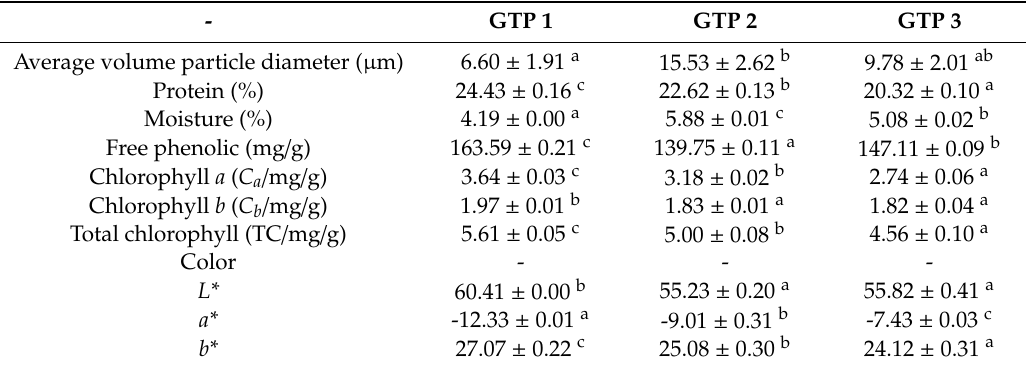
Table 1. Particle sizes, chemical components and color di ff erence of green tea powders